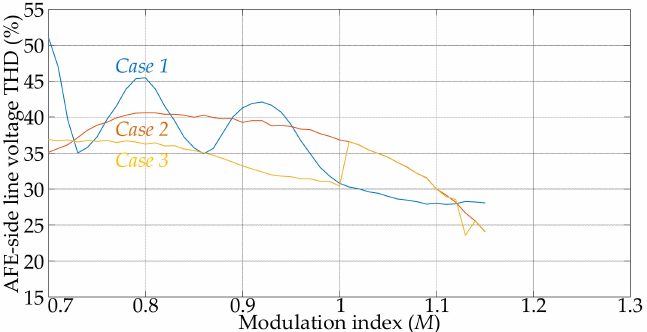
Figure 12. Comparison of AFE-side line voltage THD for these three different